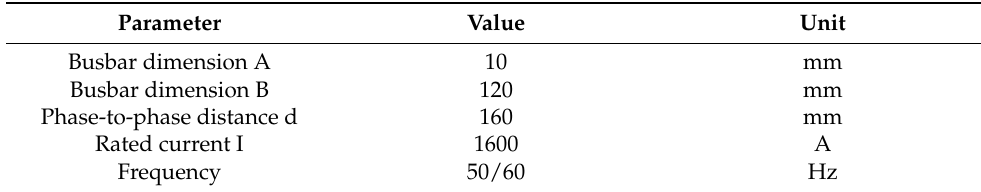
Table 4. Simulation properties for singular busbar